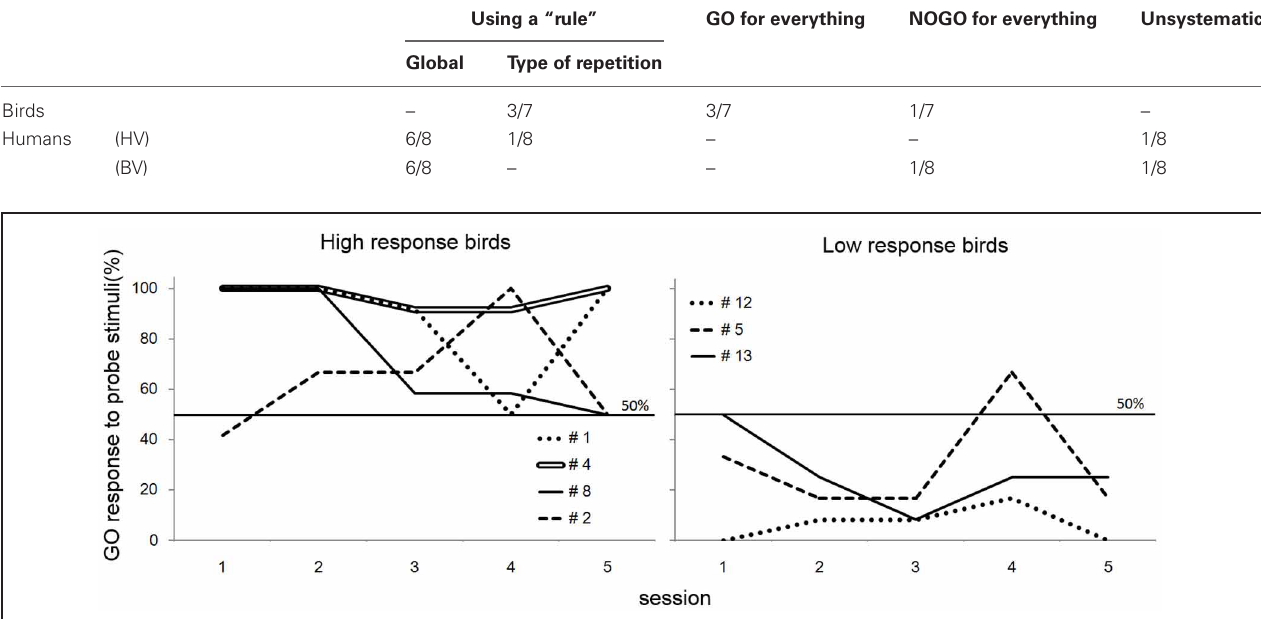
FIGURE 5 | GO response to probe stimuli of the birds in generalization test of Experiment 1. Although fluctuations are observed, there was no obvious evidence that the birds learned the consequences of the response to the probe stimuli.